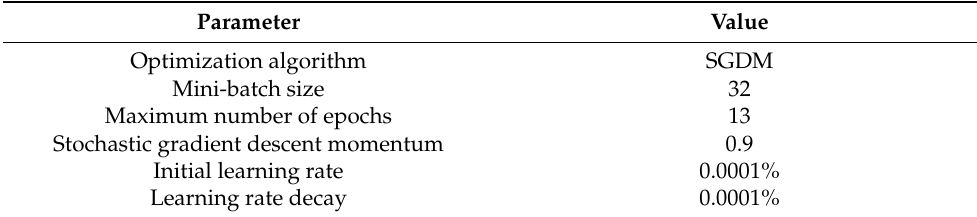
Figure 9. Neural network architecture based on VGG16. Table 5. Fine-tuning parameters for the VGG16